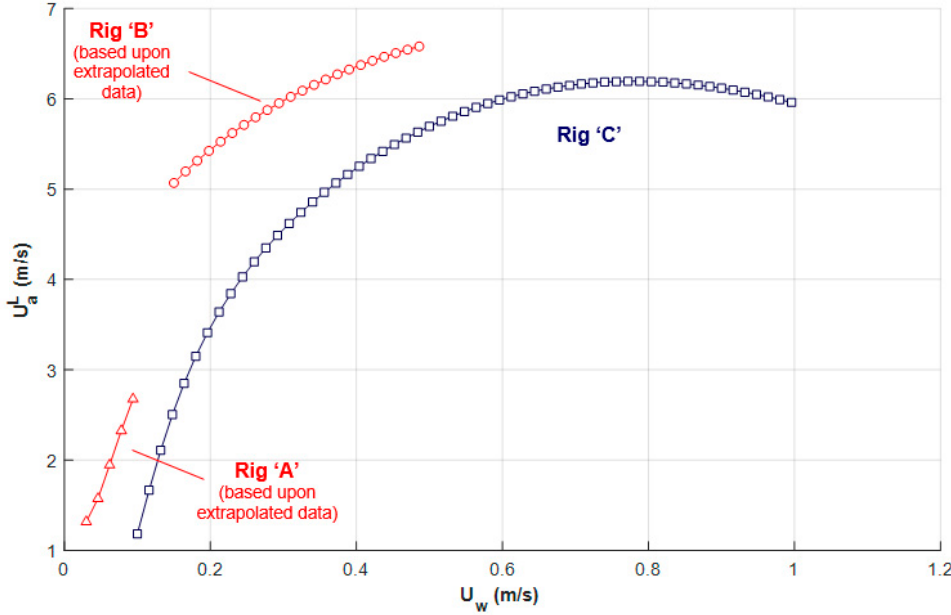
Figure 10. Limiting air velocities for Rigs ‘A’, ‘B’ and ‘C’, as derived from the empirical coefficients summarized in Table 3.